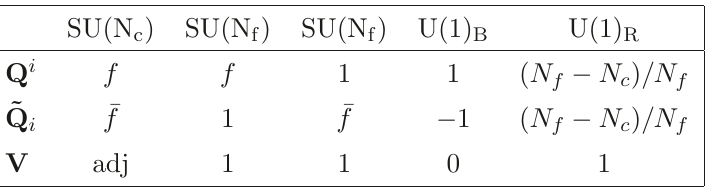
Table 1 . The matter content of and adj the adjoint